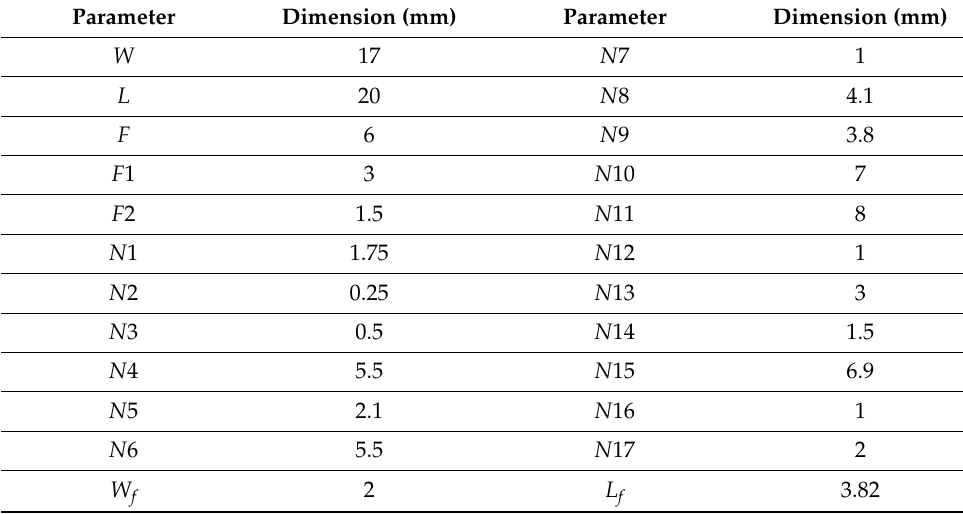
Figure 14. Detailed layout. Table 2. The designed antenna’s